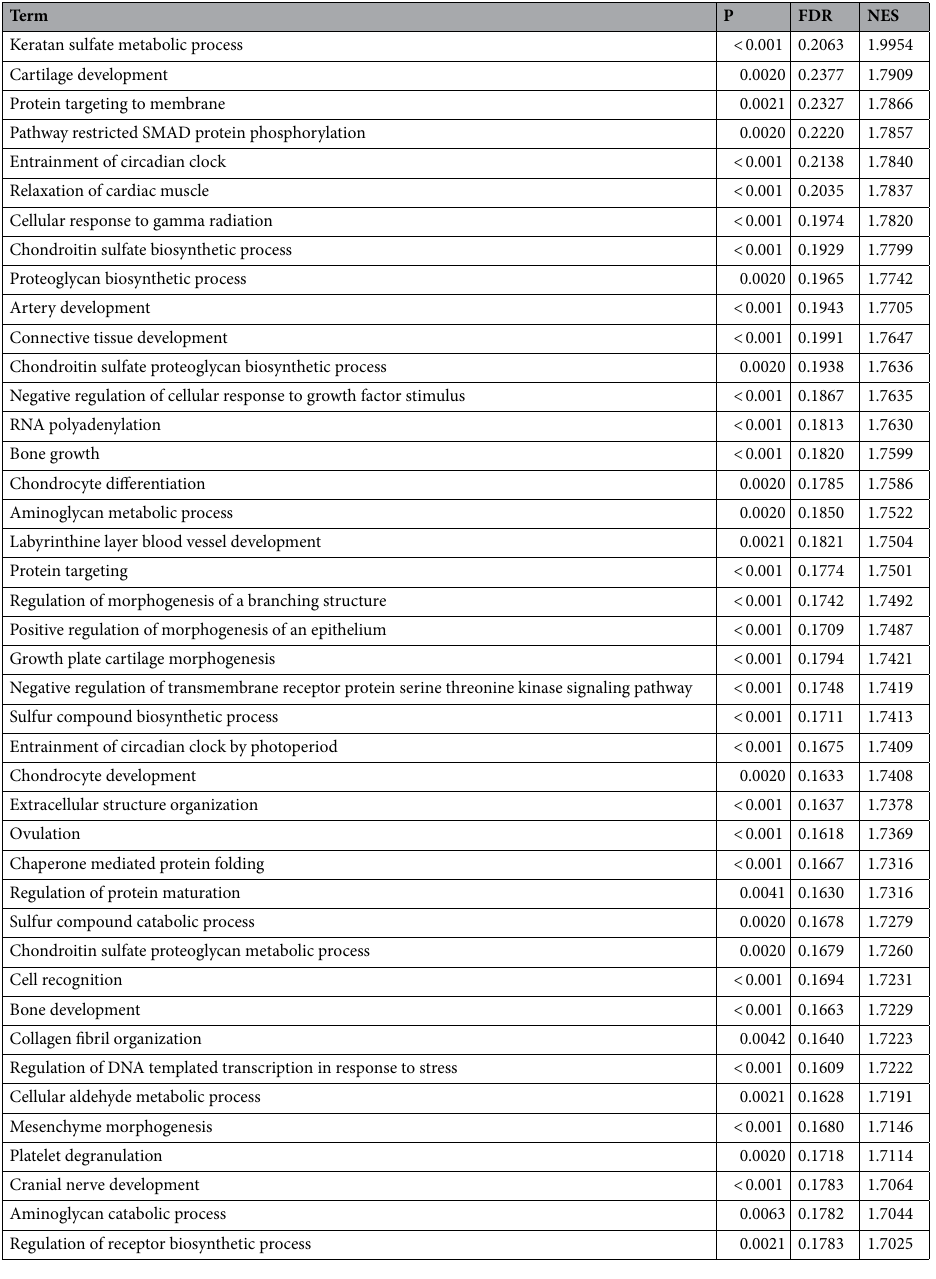
Table 6. The GSEA of CD63 for biological